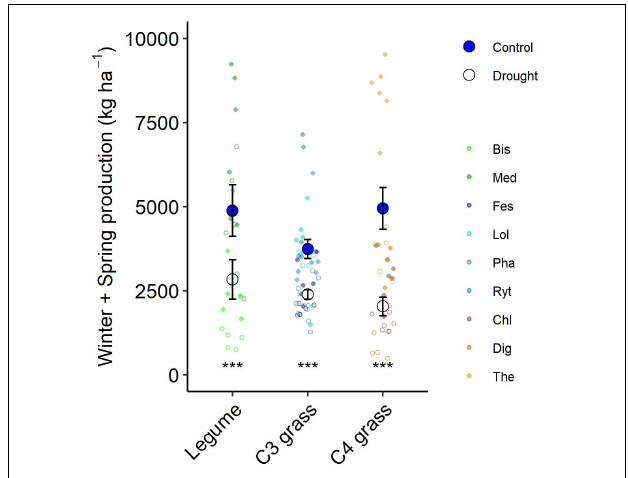
FIGURE 5 | Aboveground production summed for all harvests during the 6-month winter/spring drought period by functional group. Large points shown are means ± 1 standard error (control = solid symbol, droughted = open symbol) and opaque points show subplot level variability in biomass for each species within the functional group. Significant pairwise comparisons for the effect of drought within a functional group are indicated as described by Figure 4 .